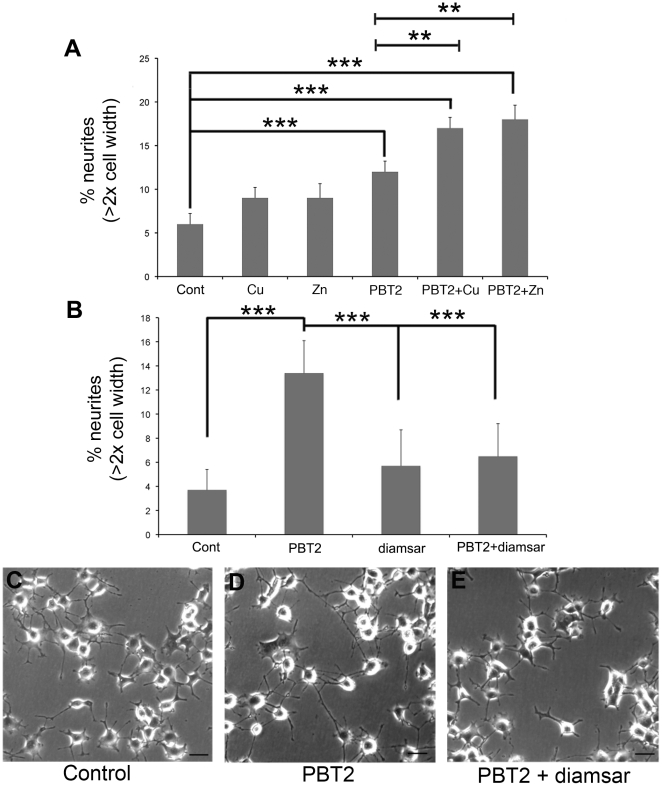
The metal-dependent effect of PBT2 on neurite outgrowth.The effects of copper and zinc alone (0.15 µM) or complexed to PBT2 (0.15 µM) were assessed. (A) PBT2 induces an increase in neurite outgrowth in PC12 cells that is exaggerated when PBT2 is complexed to either copper or zinc (n = 6/treatment). (B) The neuritogenic effect of PBT2 is abolished in the presence of the high affinity chelator, diamsar (n = 9/treatment). Neurite outgrowth in PC12 cells, under control (C), PBT2 (D) and PBT + diamsar (E) conditions is shown in the bottom micrographs (scale bar  = 200 µm). Values are mean ± SEM. **p<0.01, ***p<0.001.